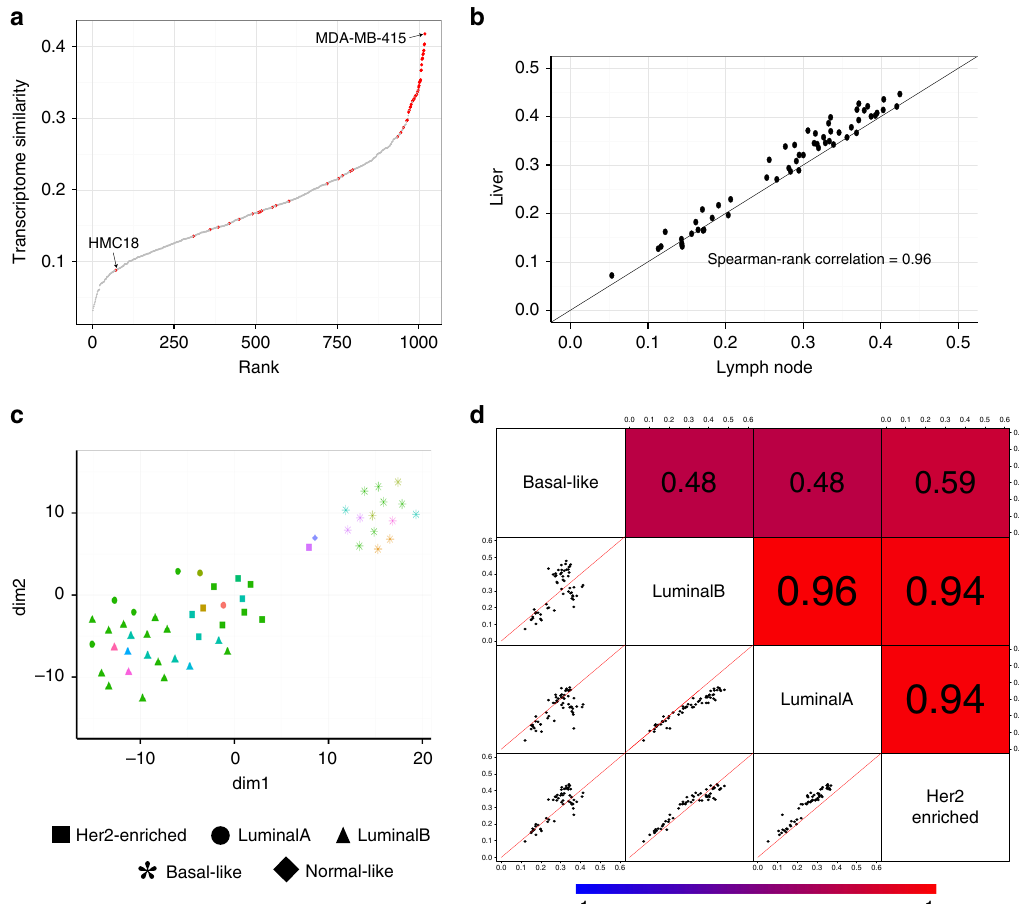
Fig. 3 TC analysis between MET500 breast cancer samples and CCLE breast cancer cell lines. a In total, 1019 CCLE cell lines are ranked according to their transcriptome similarity with MET500 breast cancer samples. Each dot is a CCLE cell line and breast cancer cell lines are marked by red. b Metastatic-site- speci fi c TC analysis results are highly correlated between liver and lymph node. Each dot is a CCLE breast cancer cell line, with x -axis representing its transcriptome similarity with the nine lymph-node-derived MET500 breast cancer samples, and y -axis representing its transcriptome similarity with the 27 liver-derived MET500 breast cancer samples. c t-SNE plot of MET500 breast cancer samples. Metastatic-sites are labeled by color and subtypes are labeled by shape. d Pair-wise comparison of subtype-speci fi c TC analysis results. In the lower-left plots, each dot is a CCLE breast cancer cell line, with the two axis representing transcriptome similarity of the cell line with MET500 breast cancer samples of the two intersecting subtypes. The upper-right shaded values are the corresponding pair-wise spearman rank correlation values of each pair. Source data are provided as a Source Data fi